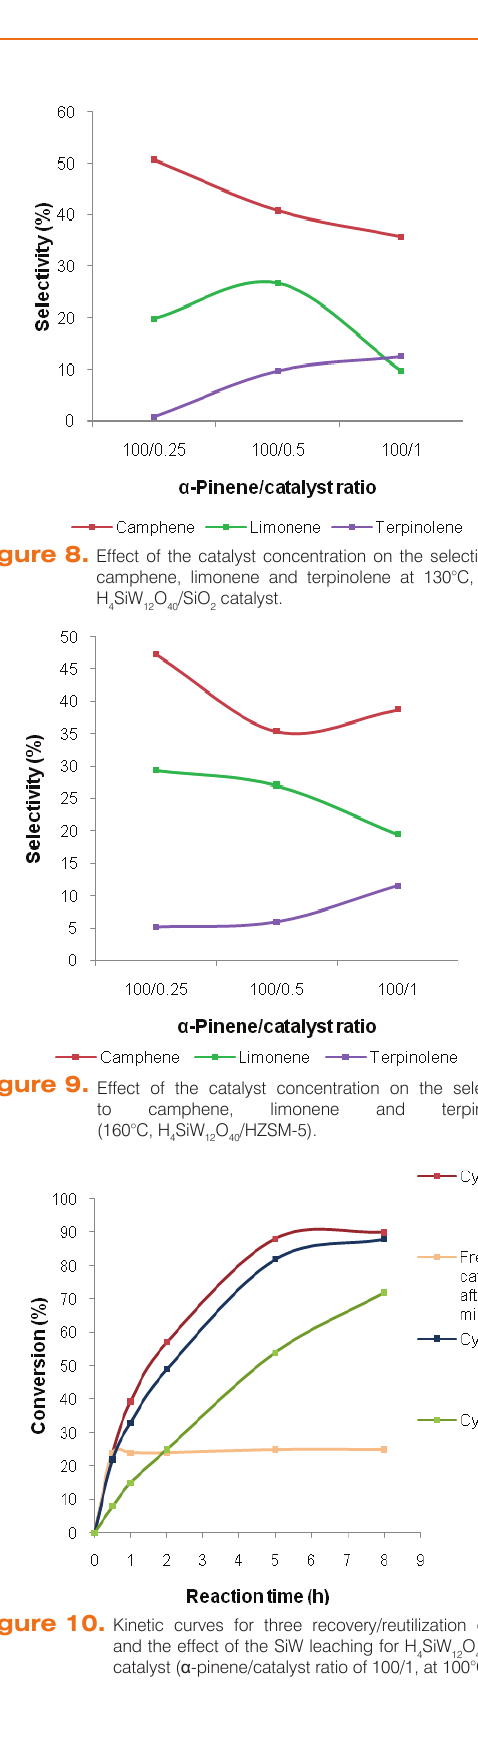
SiW O /SiO 4 12 40 2